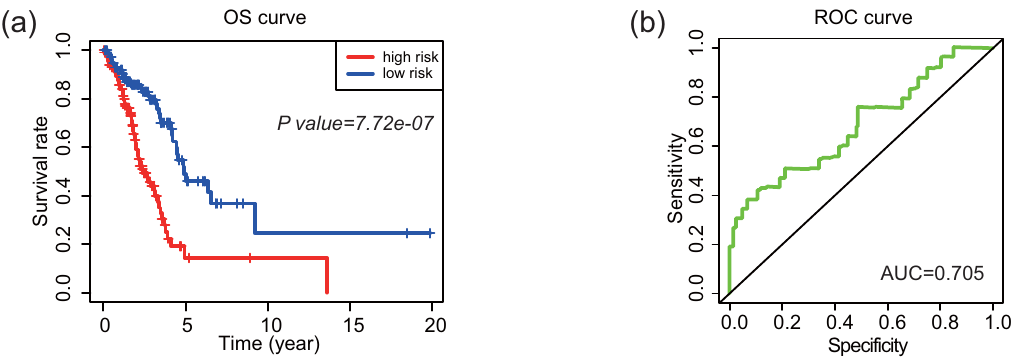
Figure 8: Veri fi cation of four - lncRNA signature in the GEO database. Kaplan – Meier survival curves for ( a ) verifying and ROC curve ( b ) for calculating the